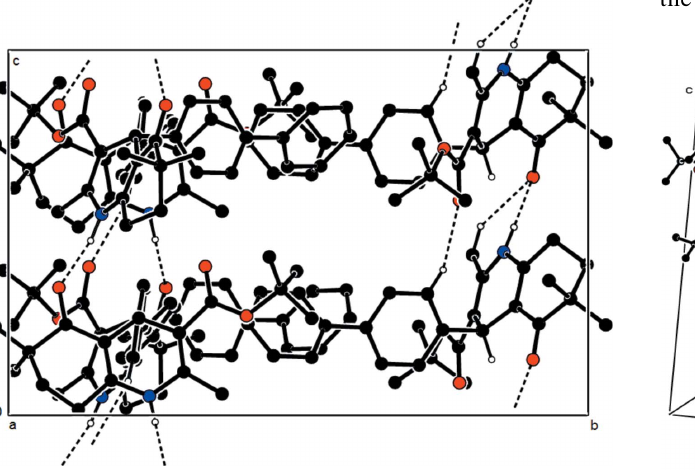
respect to the plane of the 1,4-dihydropyridine ring (N1/C1– C4/C9). The corresponding dihedral angles amount to 89.26 (16) and 75.83 (19) (cid:4) in molecule A , 88.34 (17) and 71.7 (2) (cid:4) in molecule B , and 89.38 (17) and 83.6 (3) (cid:4) in mol- ecule C . The phenyl and benzene rings of the 1,1 0 -biphenyl ring make dihedral angles of 39.05 (19) (cid:4) in A , 46.9 (2) (cid:4) in B , and 33.5 (2) (cid:4) in C . Fig. 2 shows an overlay plot of molecules A , B and C , with an r.m.s. deviation of 0.725 A˚ . Except for the atoms of the minor part of the disordered molecule C and the phenyl ring of the biphenyl group, the other atoms of molecule C and all atoms of molecules A and B are quite compatible and coincide with each other.